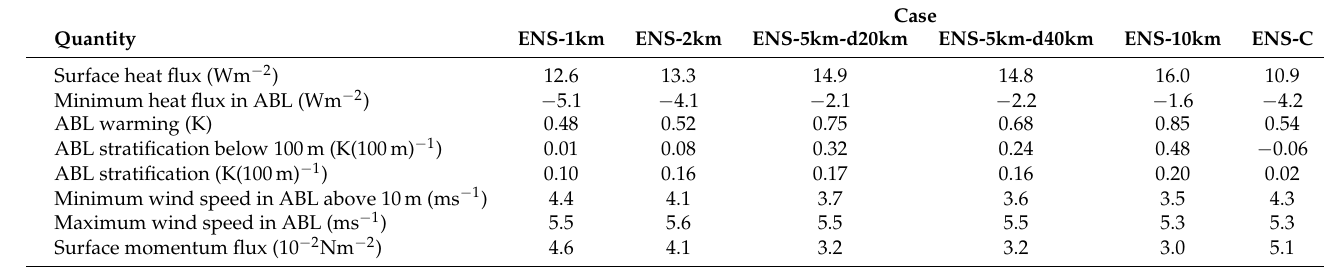
Table 2. Overview of the domain-averaged values of selected characteristic quantities obtained by the model runs NL-M20-zi for the lead-resolving cases ENS-1km, ENS-2km, ENS-5km-d20km, ENS-5km-d40km, and ENS-10km, and by the simulation NL-LS96-zi for case ENS-C. Cases and model runs are described in Figure 2 and Table 1 (see Section